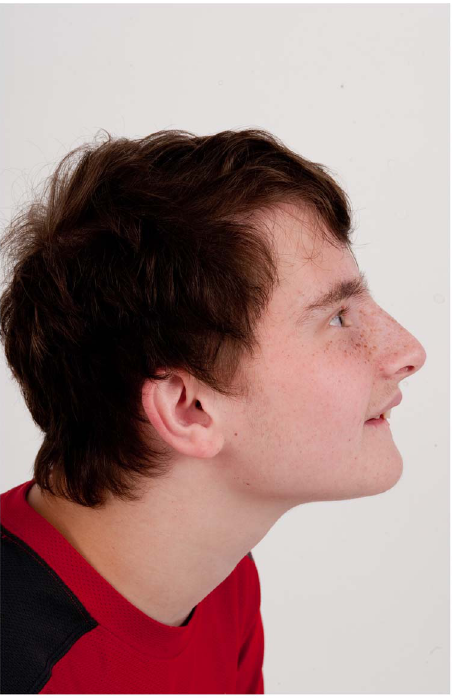
Figure 3. Frontal view of Patient 3 at age 15 years. He was originally diagnosed with Dubowitz syndrome and was determined to harbor a 3.89 Mb deletion on chromosome 17q24.2. Dysmorphic features include bilateral upslanted palpebral fissures with apparent telecanthus, broad nasal bridge and a bulbous nose.